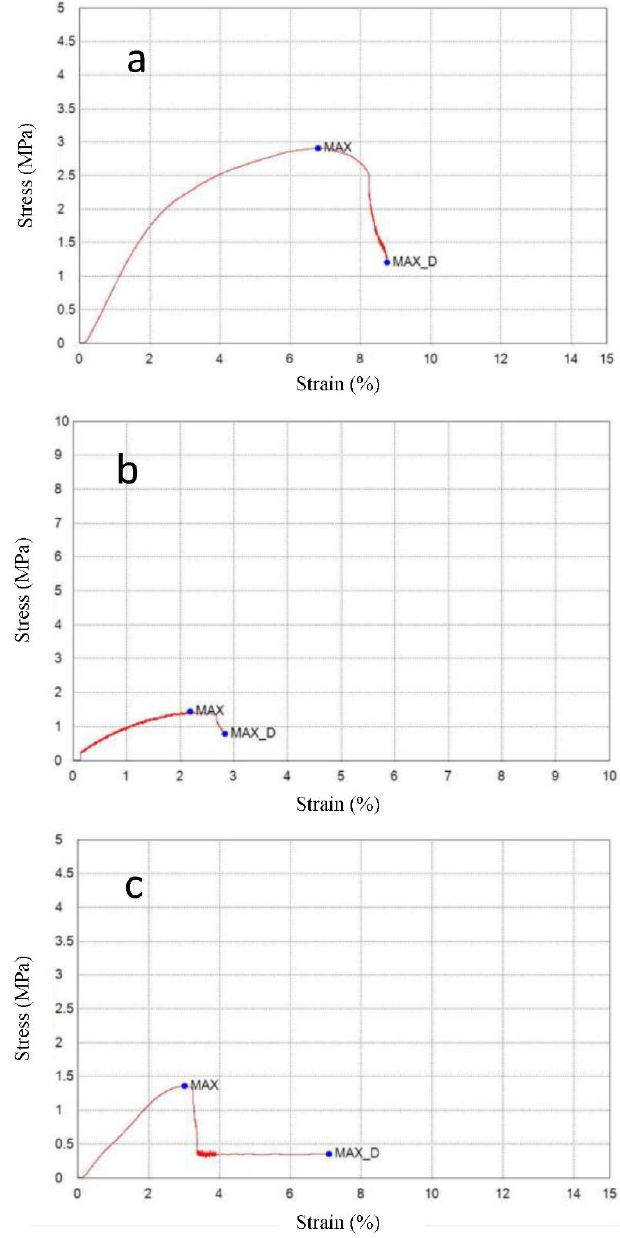
Figure 7. Tensile behavior of the bio-composite samples at various ratios of fenugreek ( a ) 5%, ( b ) 10%, and ( c ) 15%. Table 4. Comparison of tensile strength, tensile strain and Young’s modulus of the prepared sam- ples.